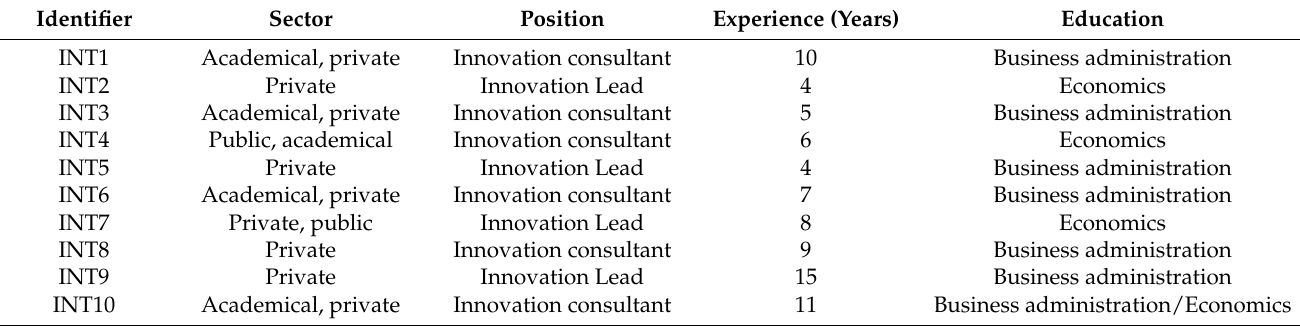
Table 5. Summary of informants.